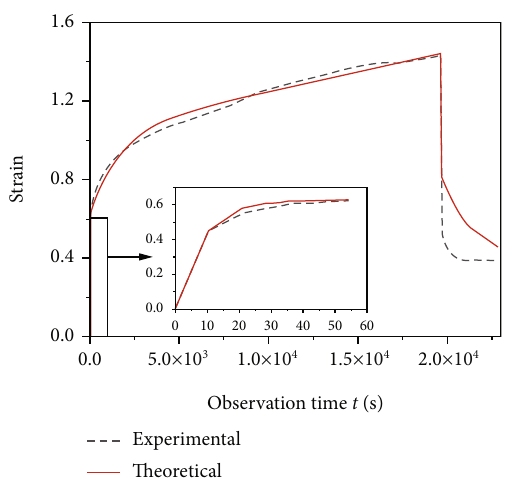
Figure 3: Creep model validation (Equation (12)) with load2 for ≈ 317 min and an overall view of the prediction of subsequent t f recovery. In inset: expanded view of creep model validation with initial creep data.